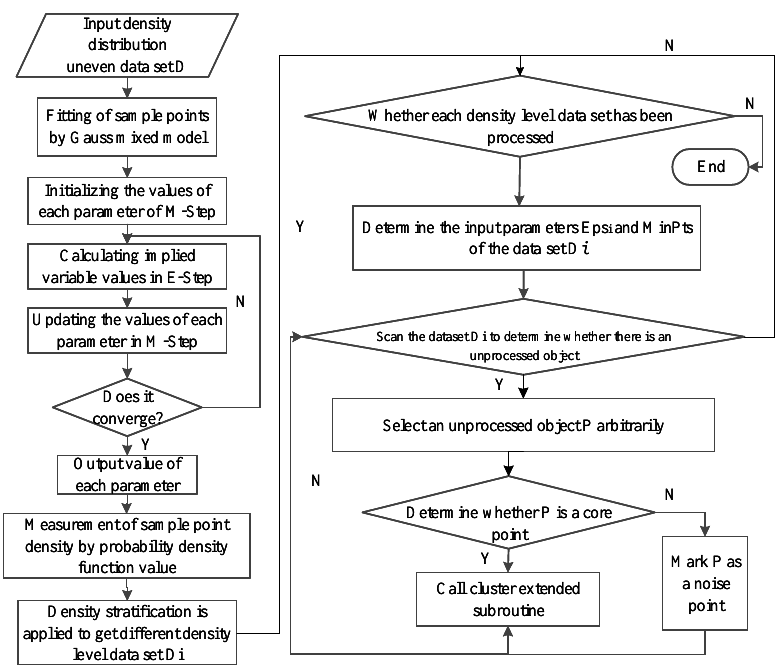
Figure 3. Flow chart of the improved